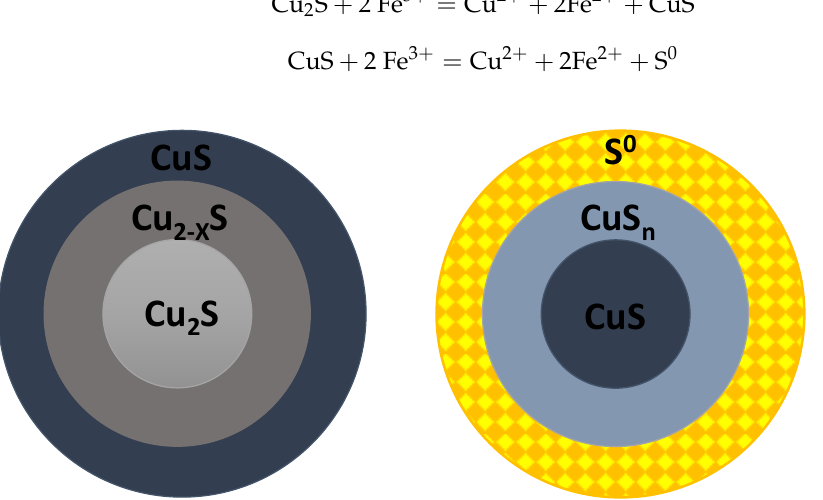
Figure 2. Graphic representation of the dissolution of the two stages of chalcocite leaching (modified from: